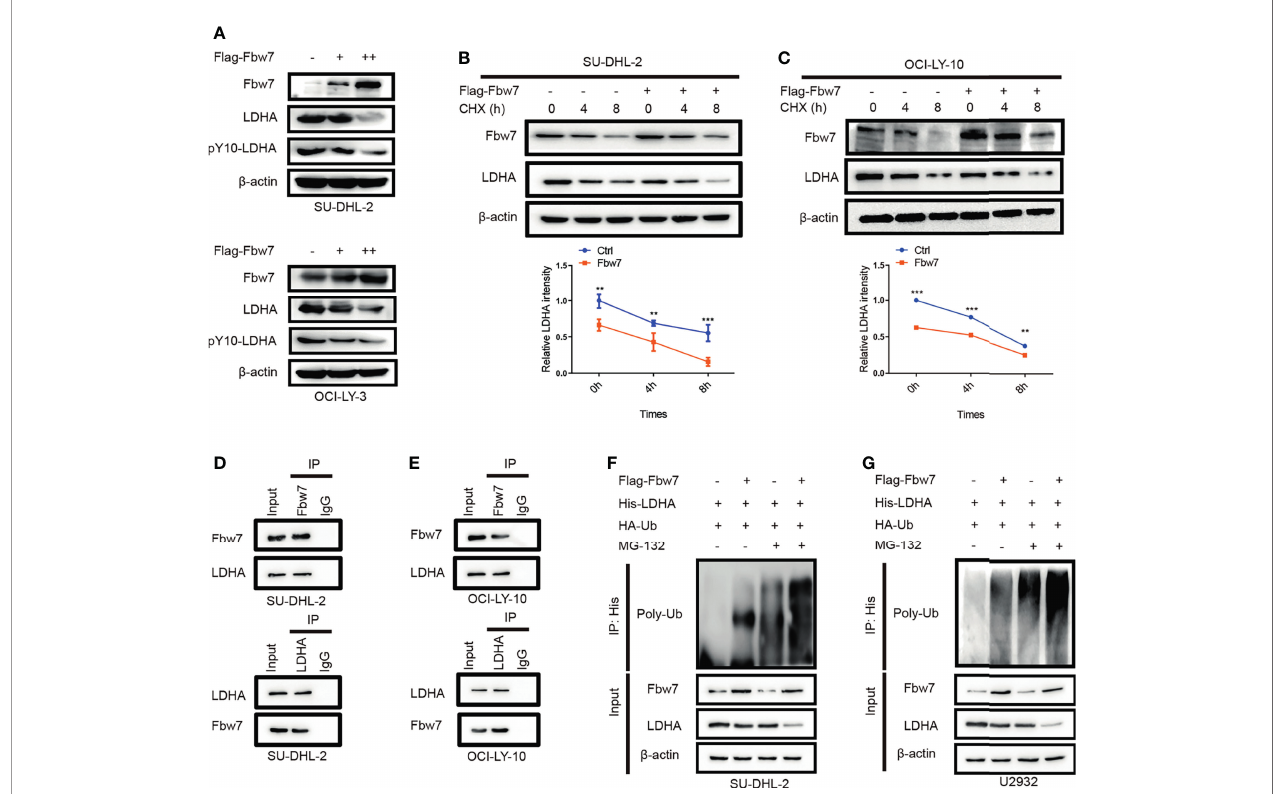
FIGURE 2 | Fbw7 interacts with LDHA and facilitates its ubiquitination and degradation . (A) Western blotting analysis SUDHL-2 and OCI-LY-3 cells transfected with Flag-Fbw7 to detect the expression of LDHA and pY10-LDHA. (B) SUDHL-2 cells were transfected with Flag-Fbw7 and treated with cycloheximide (CHX; 10 mg/ml) for the indicated time intervals to examine the stability of LDHA. Western blotting results were shown(top) and the mean ratios of the indicated proteins was quanti fi ed through densitometry in line graph(bottom). Results are displayed as mean ± SD in the line graph for three independent experiments using; **P < 0.01; ***P < 0.001; one-way ANOVA. (C) the similar results were shown in OCI-LY-10 cells. Results are displayed as mean ± SD in the line graph for three independent experiments using; **P < 0.01; ***P < 0.001; one-way ANOVA. (D, E) . interaction between endogenous Fbw7 and LDHA in indicated cell lines. Cell lysates from SU- DHL-2 and OCI-LY-10 cells were co-immunoprecipitated with anti-Fbw7 or anti-LDHA antibody and the original results were analyzed by western blotting. IgG was used as a control. (F, G) SU-DHL-2 and OCI-LY-10 cells were transfected with the indicated plasmids. Cells were treated with 10 mM MG132 for 6 hours